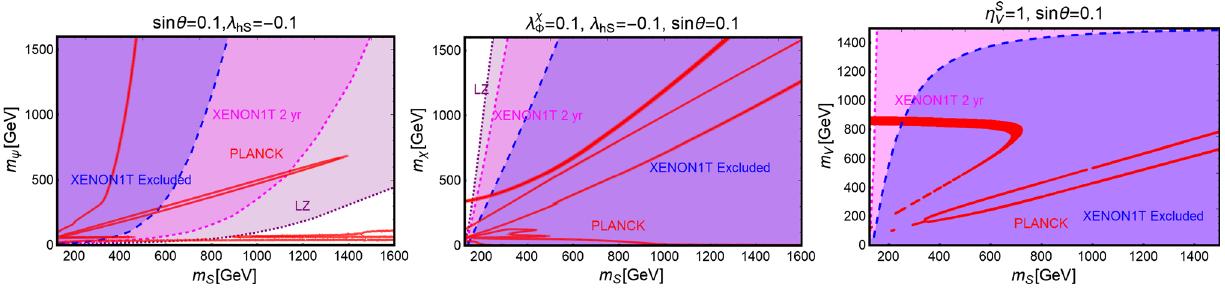
Fig. 21 Summary of constraints for the SM-Higgs + spin-0 portal for a scalar (left), Dirac fermion (middle) and a vectorial (right) DM in the relevant bi-dimensional planes, ( m S , m χ ), ( m S , m ψ ) and ( m S , m V ) , respectively. The red contours represent the correct DM relic density